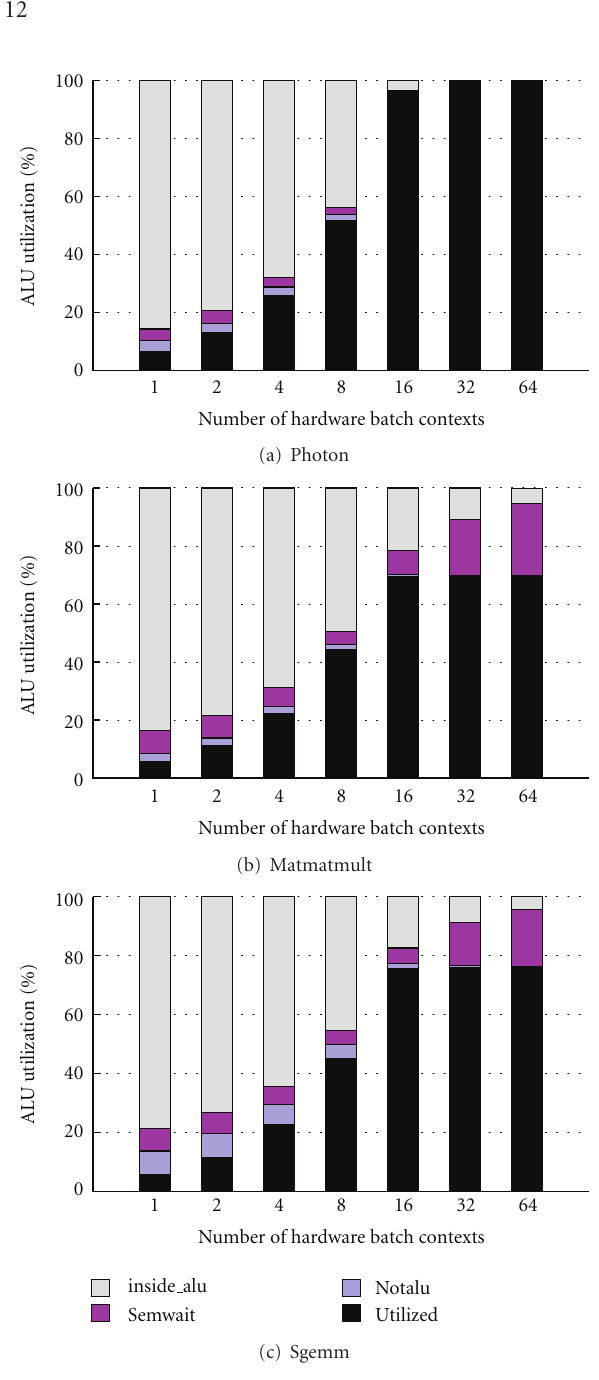
Figure 10: ALU datapath utilization for the 8-bit HT interface provided with the XD1000